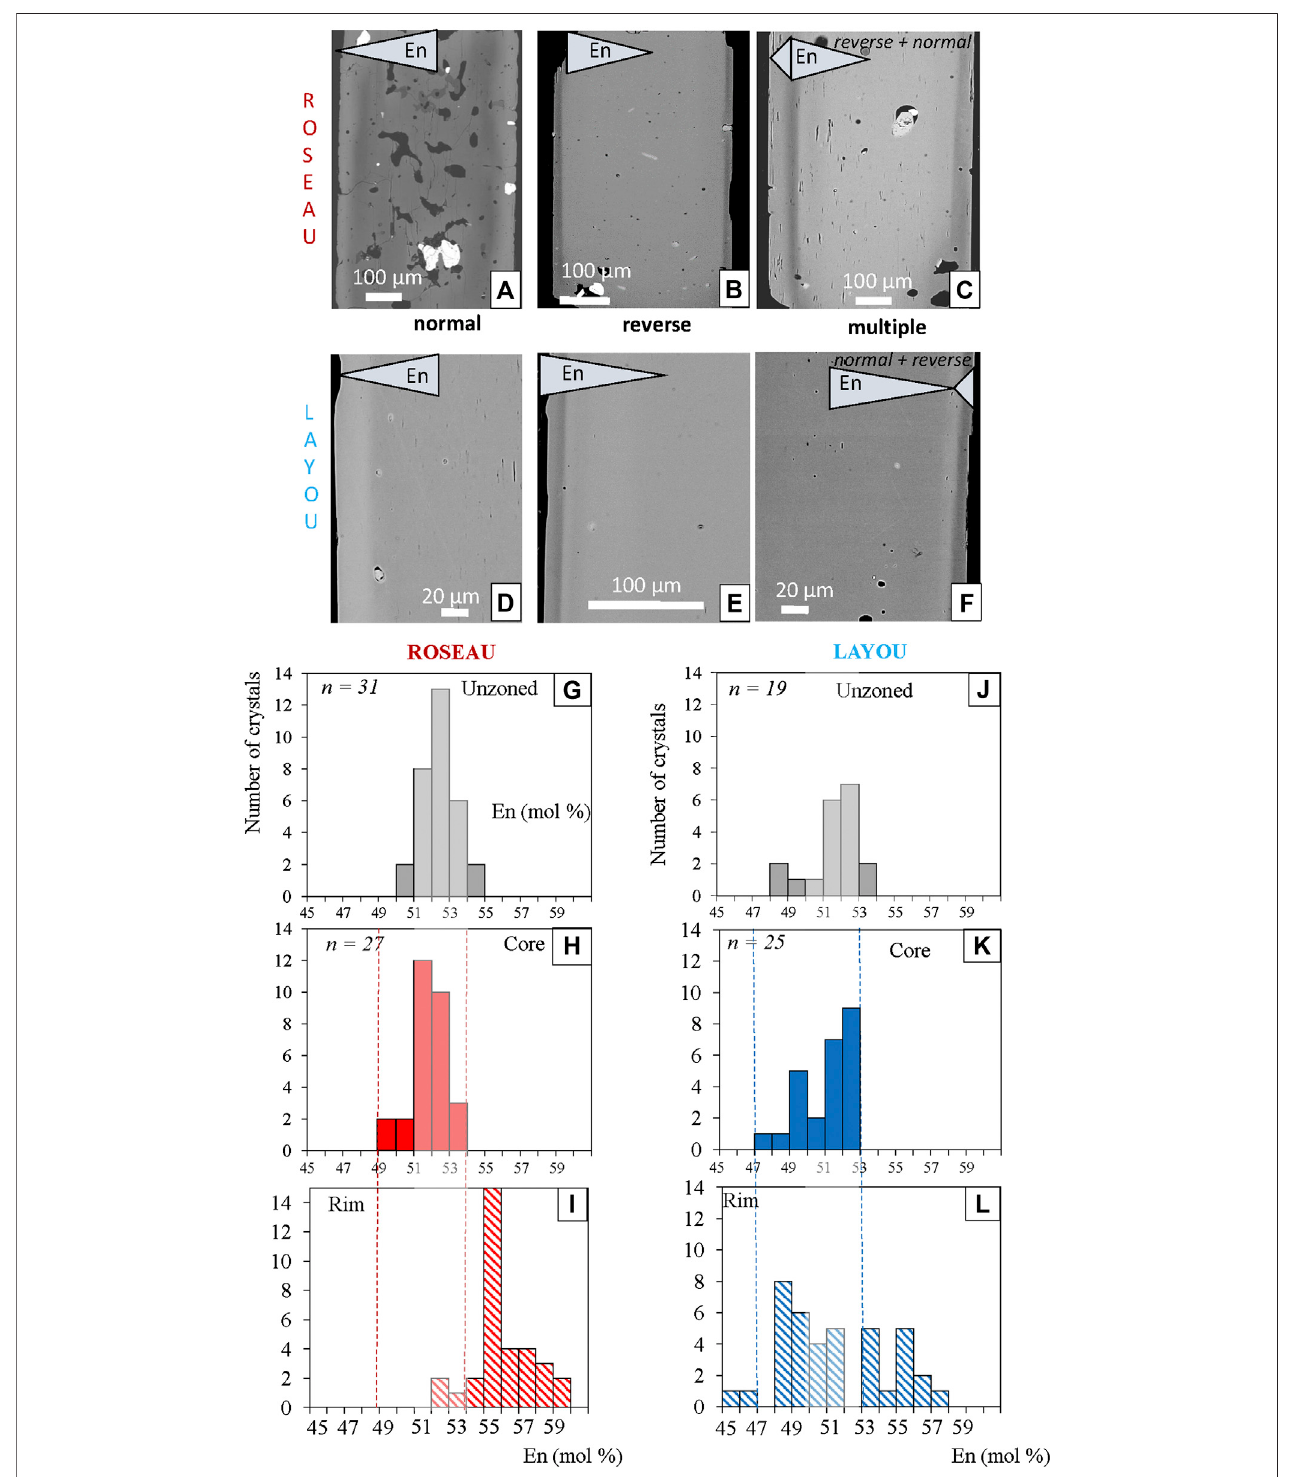
FIGURE 3 | Overview of opx textures and composition. Selected SEM images illustrating the opx zonations for Roseau (A: normal; B: reverse; C: multiple, reverse+normal) and Layou (D: normal; E: reverse; F: multiple, normal+reverse). Frequency histograms of the zoned and unzoned orthopyroxene compositions in Roseau (leftside) and Layou (rightside) expressed interms ofEn(mol%). (G,J) unzoned crystalsingrey; (H,K) cores ofzonedcrystalsinbluefor Layou and red for Roseau; (I, L) rimsofzonedcrystals,indashedbluefor Layouanddashedred forRoseau. Unzonedorthopyroxenecompositions:singlepointanalysesinthecrystalcore.Coreand rim composition: averaged plateau compositions of the zoned crystals, with a minimum length of ∼ 15 μ m. N: number of crystals.